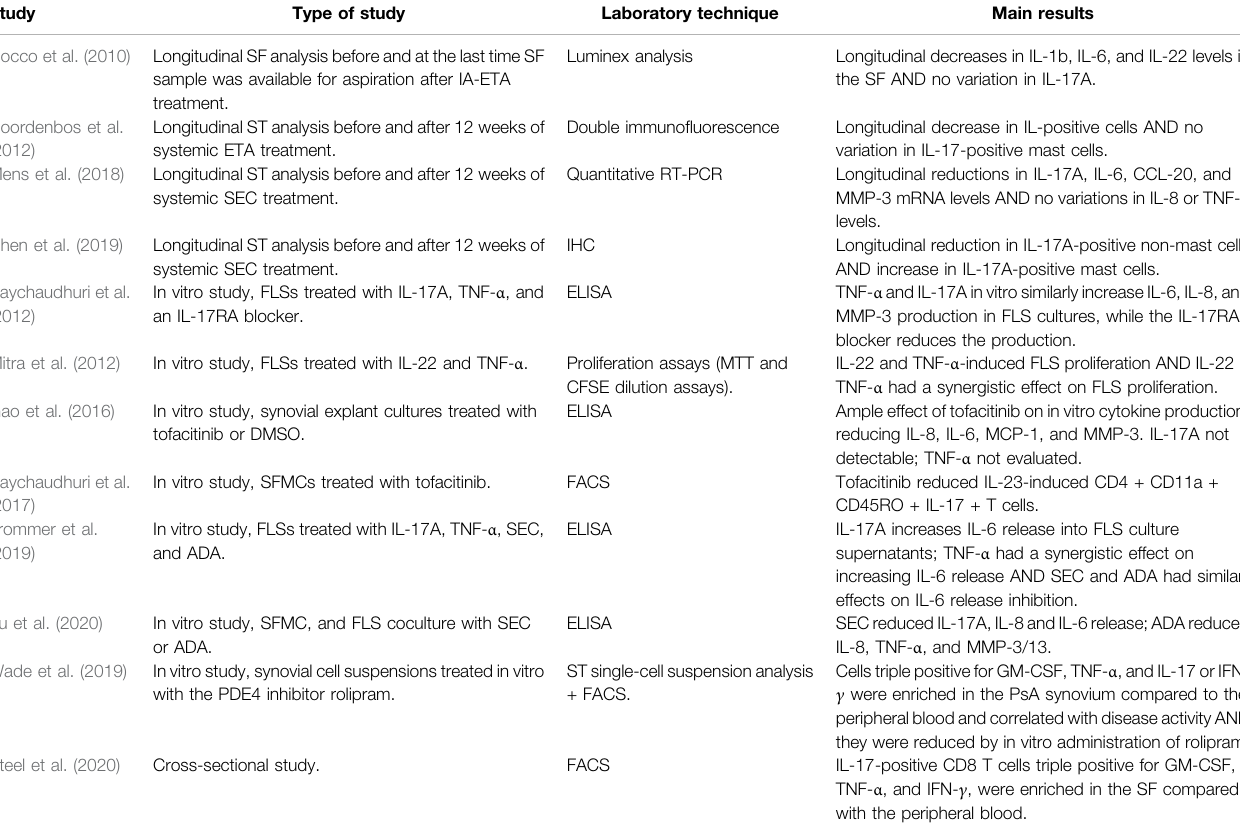
TABLE 3 | Main studies investigating the relationships between TNF- α - and IL-23/IL-17A-driven proin fl ammatory pathways in psoriatic